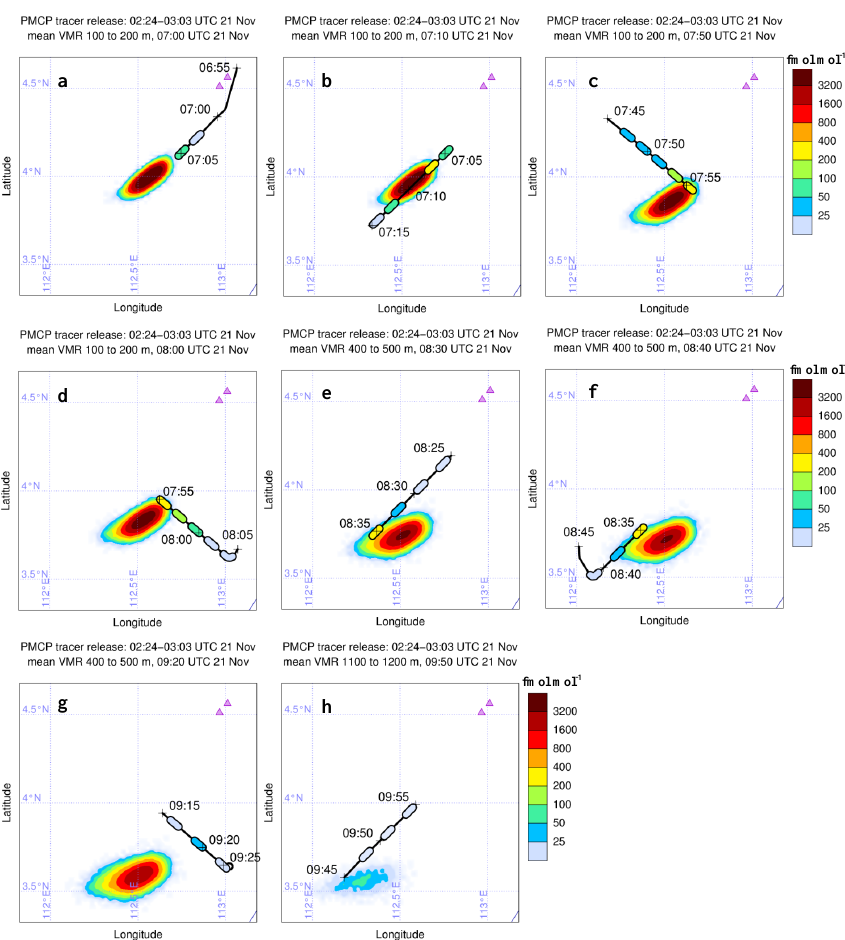
Figure 8. Time snapshots of the simulated tracer plume with HYSPLIT using analyzed meteorological fields (big plume) on 21 November, and the corresponding sampling tracks (black line). (a and b) The plume at t = 07:00 and 07:10UTC, (c and d) the plume at t = 07:50 and 08:00UTC, (e and f) the plume at t = 08:30 and 08:40UTC, (g) the plume at t = 09:20UTC, and (h) the plume at t = 09:50UTC. The volume mixing ratio (VMR) is calculated as mean value within vertical layers of 100m thickness, for (a – d) 100–200m, for (e – g) 400–500m, and for (h) 1100–1200m. Small colored ovals represent the samples collected along the flight track (same color scale as used for the HYSPLIT data). Two purple triangles indicate the positions of the start and the end of the tracer